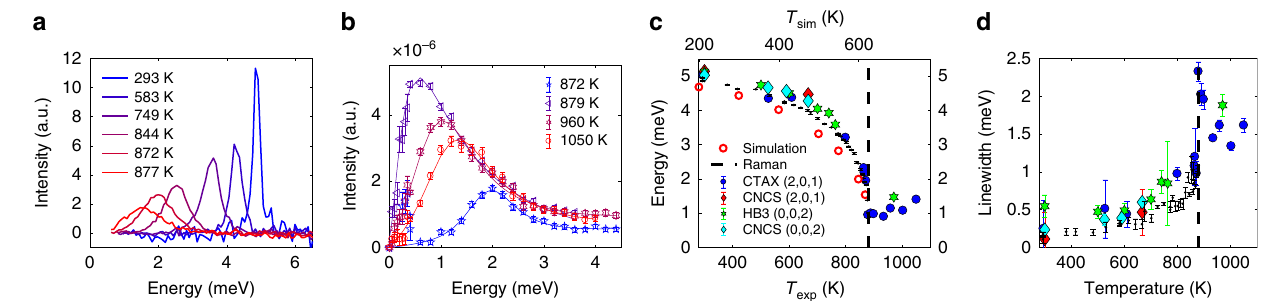
Fig. 3 Soft mode behavior. Temperature evolution of the soft phonon mode across the phase transition in SnS. a χ ″ ( E ) spectra from Raman scattering showing TO c mode as a function of temperature. b χ ″ ( Q = (2, 0, 1), E ) phonon spectra from INS (CTAX) at temperatures near and above T C . Error bars are from Poisson statistics and represent one standard deviation. c , d Soft mode energies and linewidths (full width at half maximum) extracted from fi tting INS and Raman data ( fi tting procedure described in “ Methods ” ), compared with simulations. The vertical dashed line represents T C . The energies from simulations are derived from a linear interpolation of Φ (2) between 0 K DFT and 600 K TDEP. In c the simulation temperatures are shown on a separate axis with the theoretical T C = 624K aligned with the experimental T C = 880 K. Error bars for the neutron data in ( c , d ) represent one standard deviation obtained from fi tting using Reslib whereas those for Raman data represent a 95% con fi dence interval from the fi tting